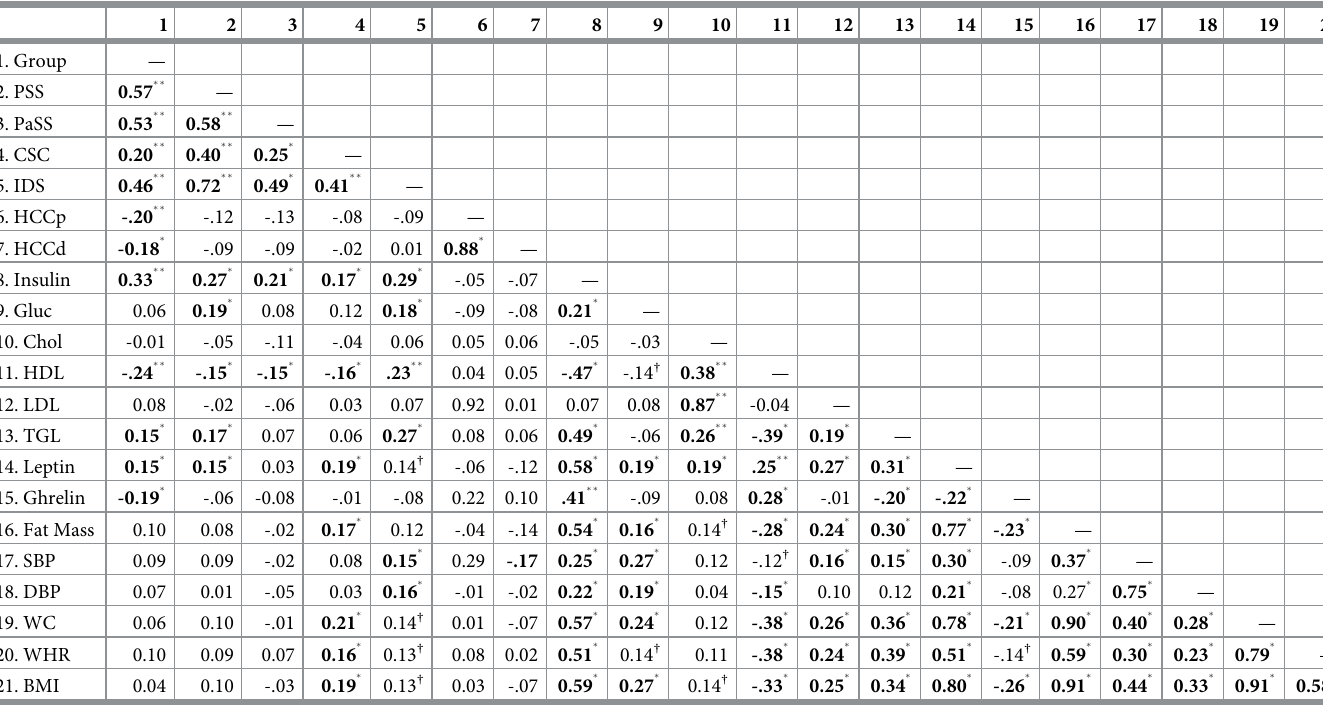
Table 3. Correlations among study variables at baseline.